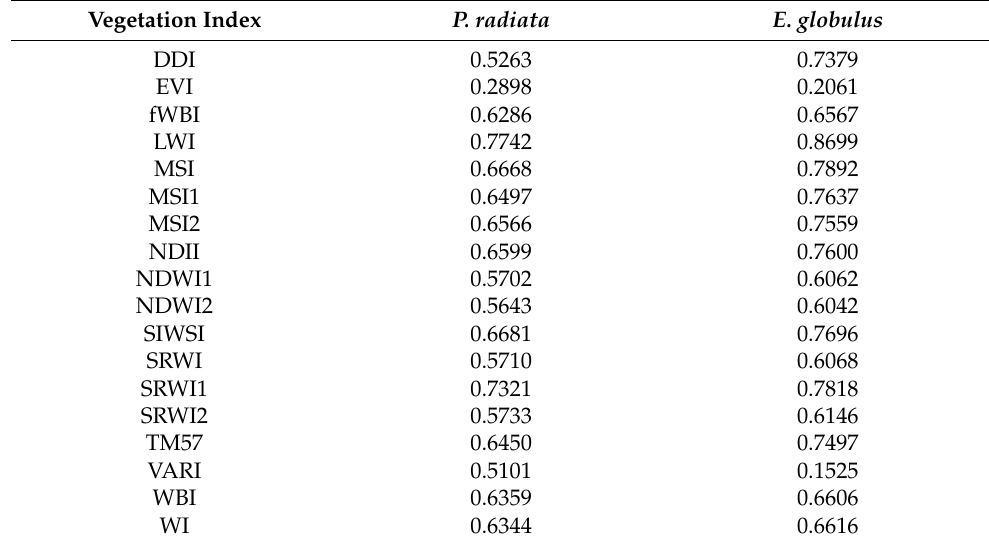
Table 4. Coefficient of determination for the FMC vs VI models using the fitting set. Vegetation